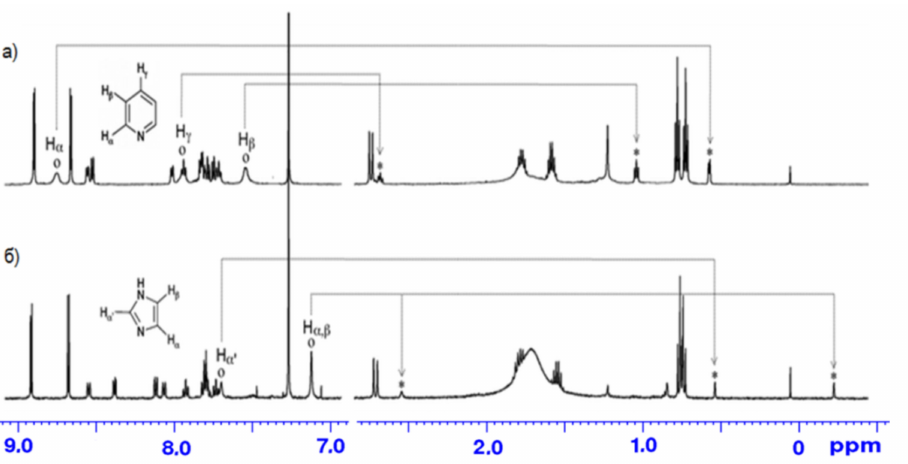
Figure 1. 1 H-NMR spectra of the 7-Py ( a ) and 7-Im ( b ) complexes in CDCl 3 at 298 K. The o and * symbols denote the signals of the free and bound substrate molecules [47].